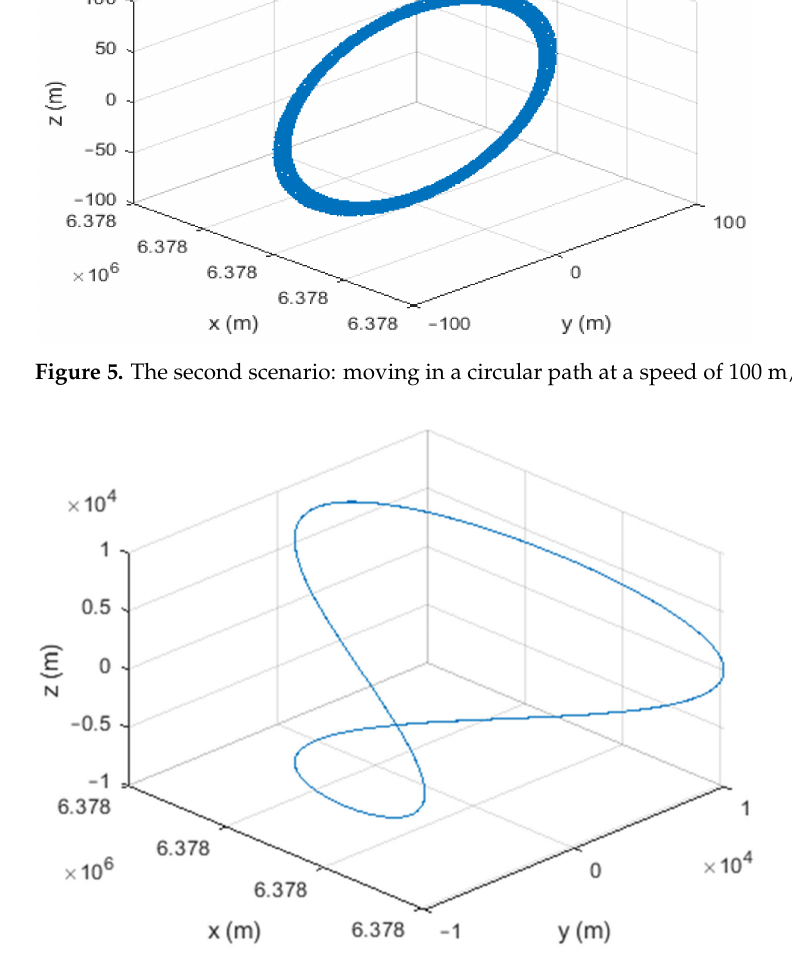
Figure 6. The third scenario: moving in a circular path at a speed of 500